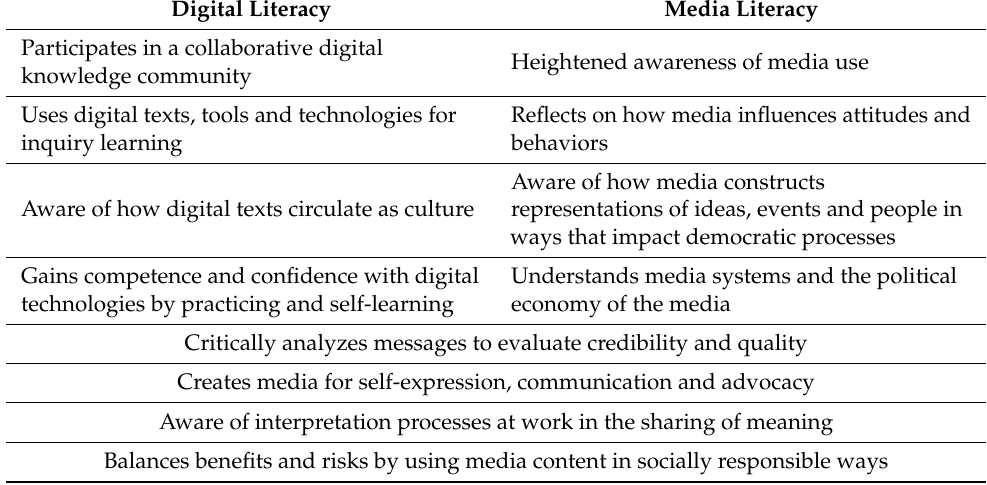
Table 1. Digital Literacy and Media